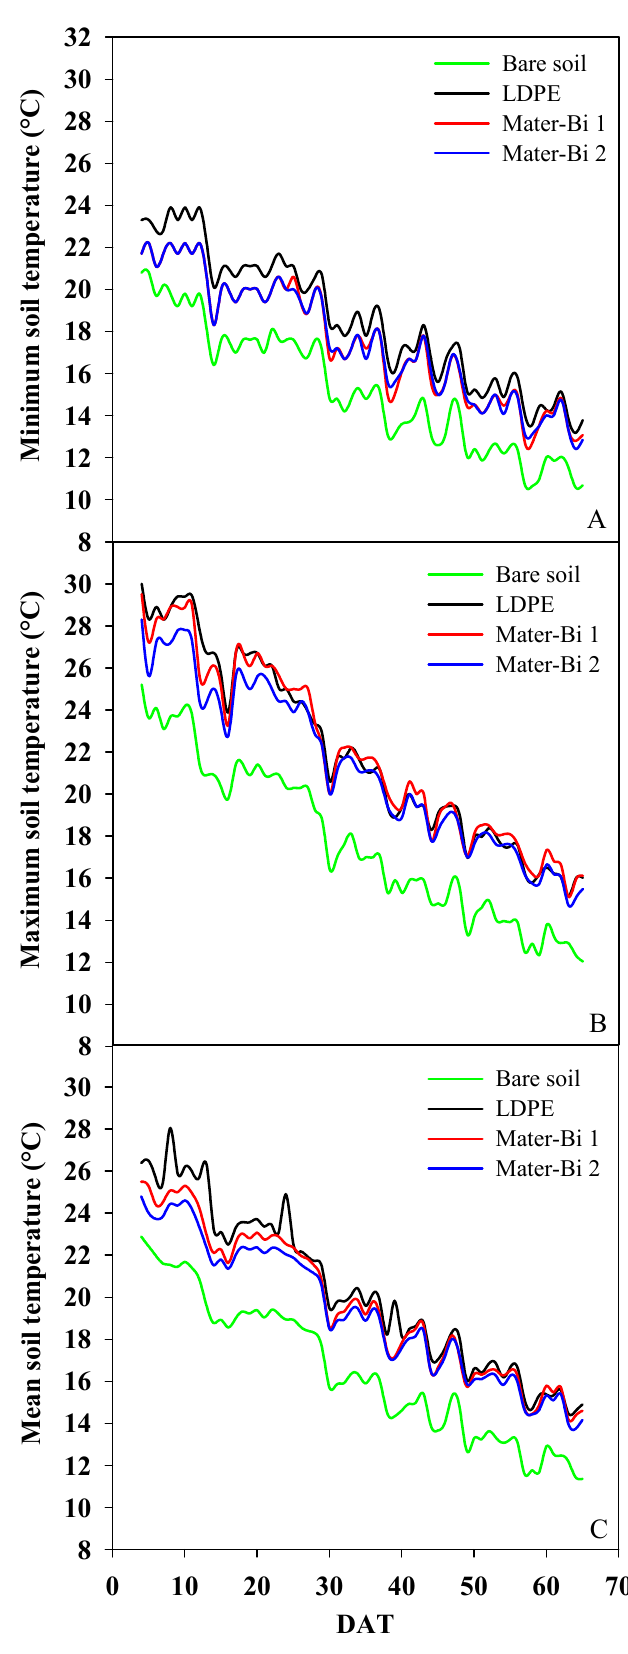
Figure 2. Daily minimum ( A ), maximum ( B ), and mean ( C ) values of soil temperature recorded at a depth of 10 cm in bare soil, LDPE, Mater-Bi ® 1 and Mater-Bi ® 2 mulches.